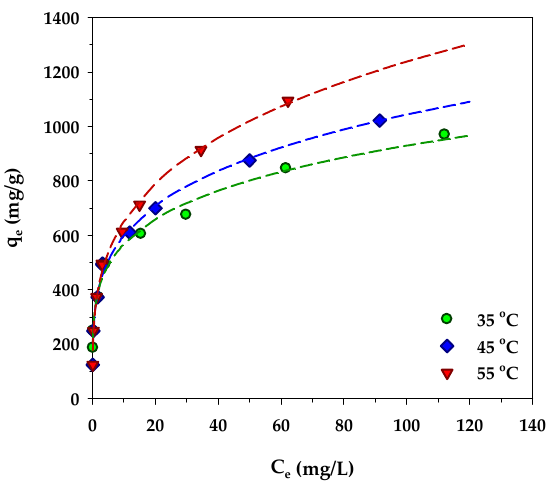
Figure 11. Effect of temperature on isotherms of MB adsorption by the mesoporous-activated carbon (A6).